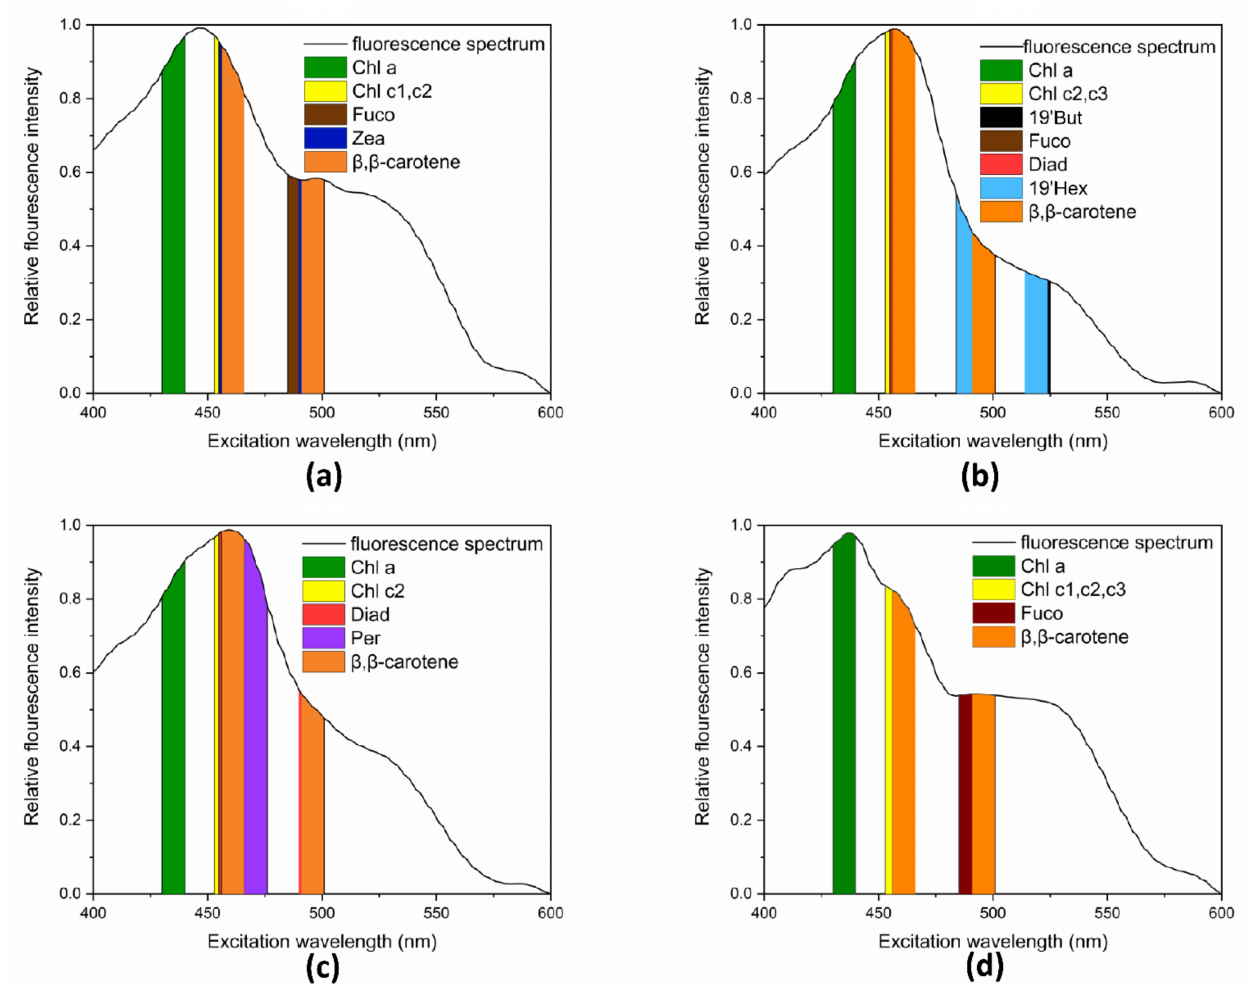
Figure 3. Excitation fluorescence spectra measured at the exponential growth phase under the condition at 20 ◦ C, 30‰ and 100 µ mol m − 2 s − 1 of light intensity with a 12:12 light:dark cycle, and the location of peaks of pigments of algae: ( a ) CM (from Raphidophyta ), ( b ) PG (from Haptophyta ), ( c ) AC (from Dinophyta ), and ( d ) SC (from Bacillariophyta